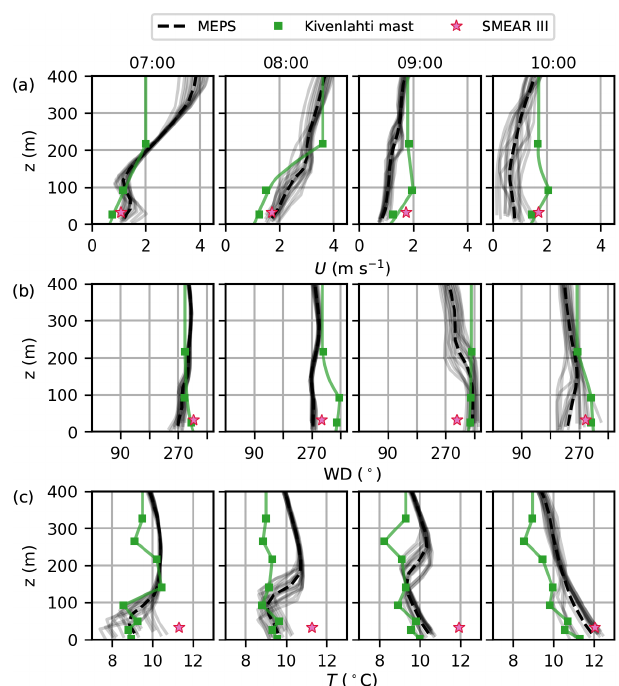
Figure 2. Horizontal (a) wind speed U (ms − 1 ), (b) WD ( ◦ ) and (c) air temperature T ( ◦ C) on 9 June at local time (UTC + 3). The modelled profiles at each MEPS grid point are shown by solid grey lines and their mean by a dashed black line. The observations from the Kivenlahti mast are shown by solid green squares and the inter- polated profiles used as boundary conditions by a solid green line. Stars show the SMEAR III